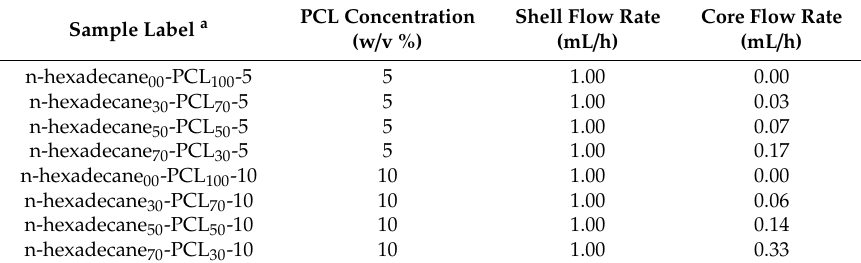
Table 1. Solutions and process flow rates used for the mPCM